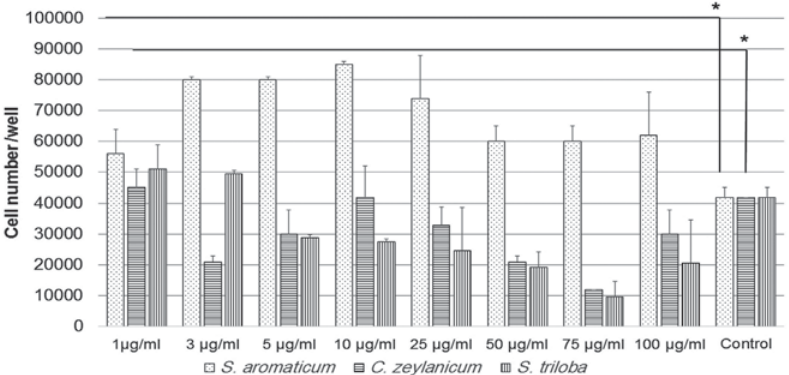
Figure 2- Viability of dental pulp stem cells (DPSCs) treated with different Extracts. Trypan bBue assay showed S. aromaticum had no toxic effect on the cells. C. zeylanicum and S. triloba reduced cell viability after 10 μ g/mL. Increased concentration reduced the cell number in S. aromaticum and C. zeylanicum in a negative strong